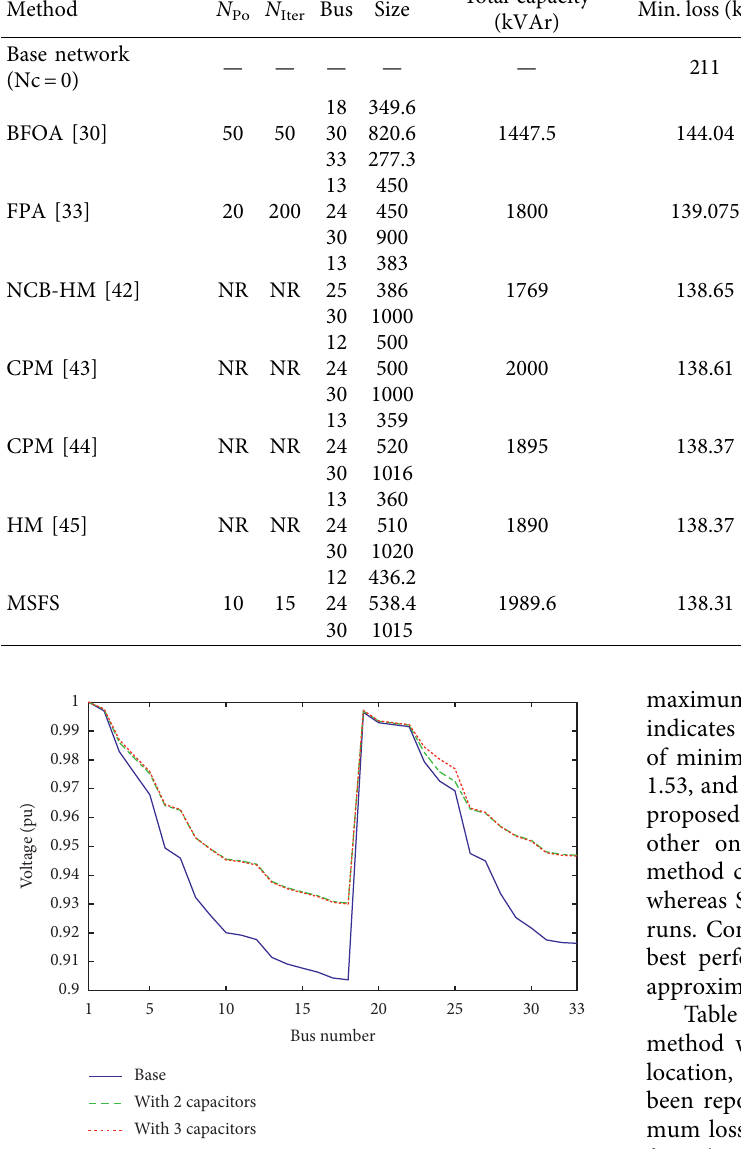
Figure 9: Voltage profile of the 33-bus network for different cases of capacitor